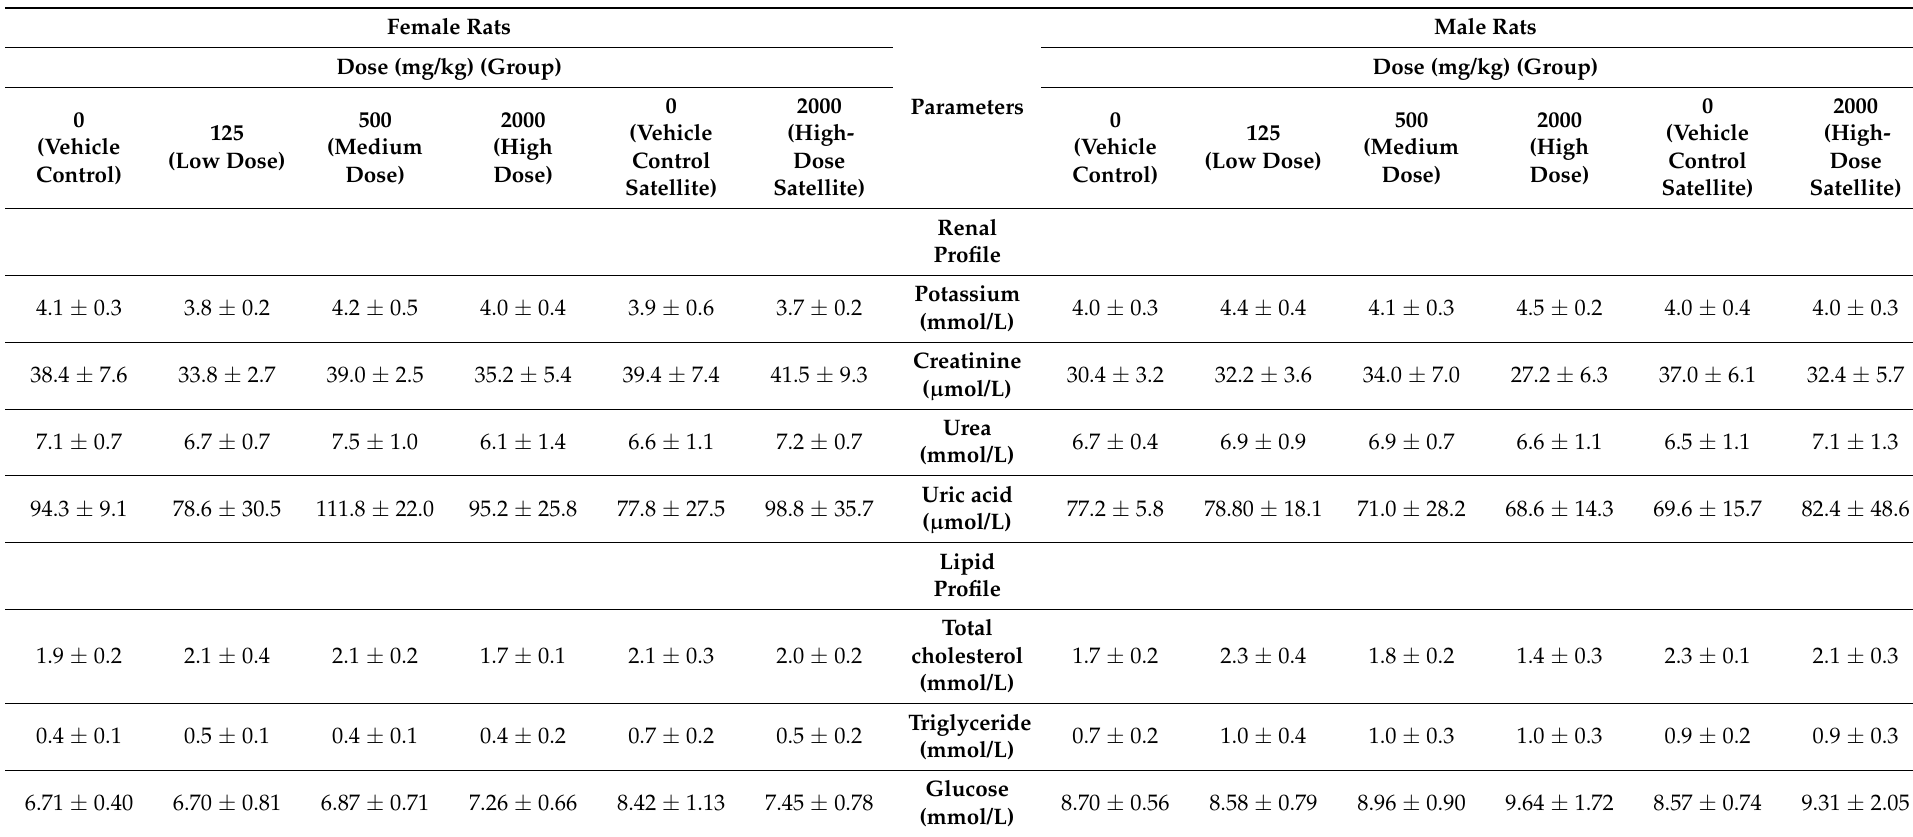
Table 8. Clinical biochemistry renal and lipid profile parameter on female and male